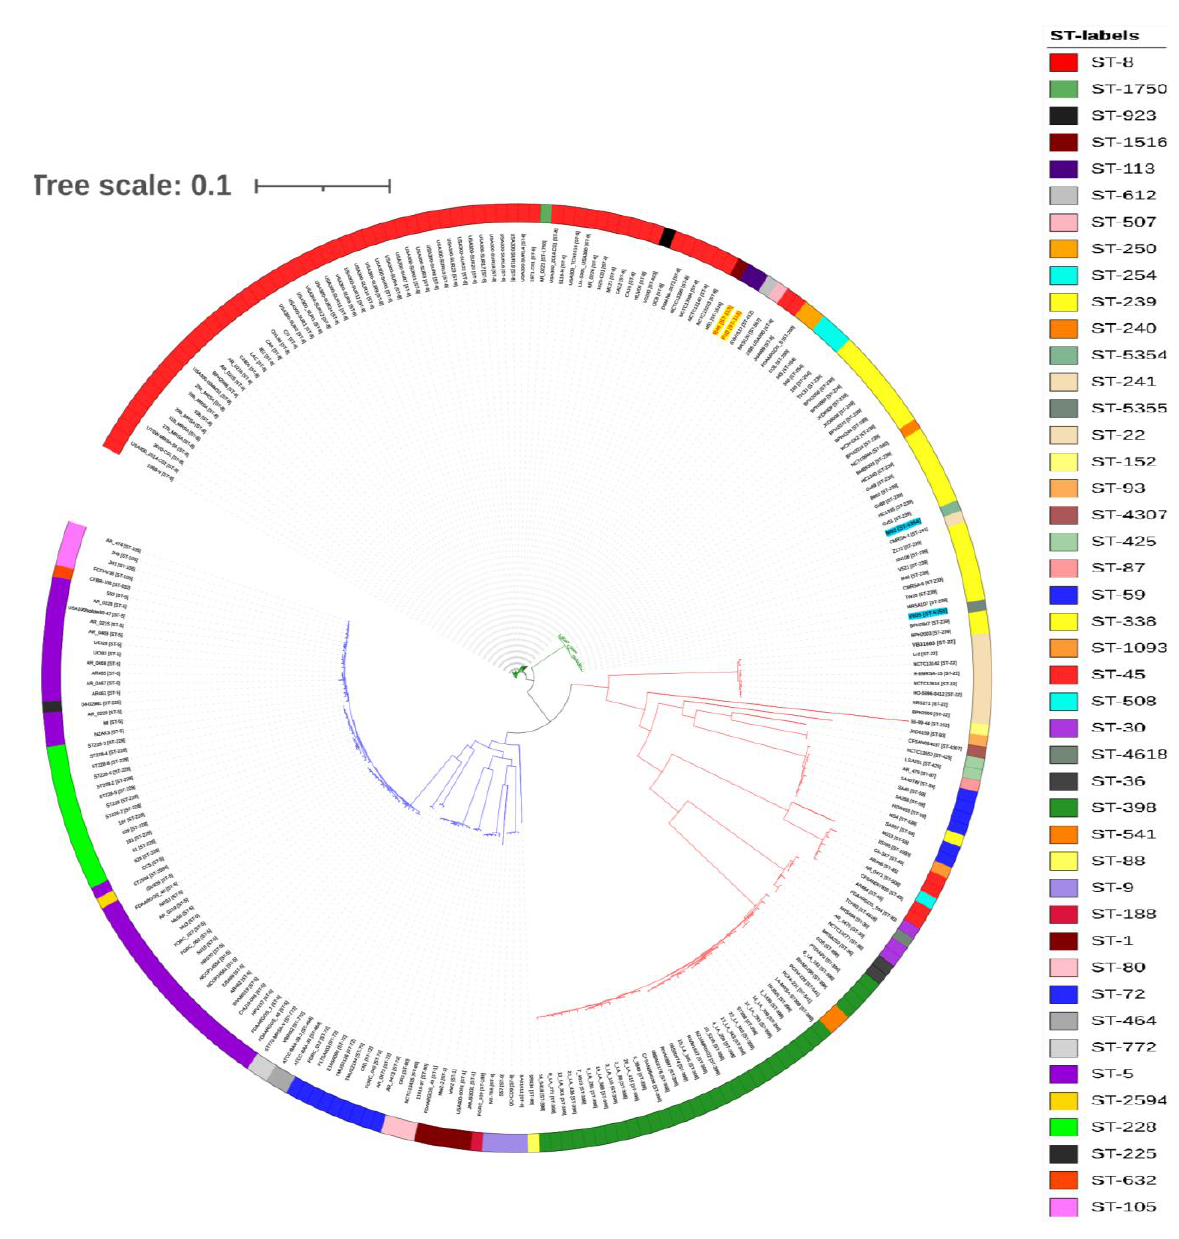
Figure 3. Circularized SNP tree of 253 (test strains n = 2, and global strains n = 251) MRSA genomes. The Maximum Likelihood tree generated by the single nucleotide polymorphisms (SNPs) with the reference genome USA300_FPR3757, which is not shown in the tree. The test strains are colored in red, boldfaced, and highlighted with a yellow background. Color keys indicating ST numbers are provided alongside the circularized tree.